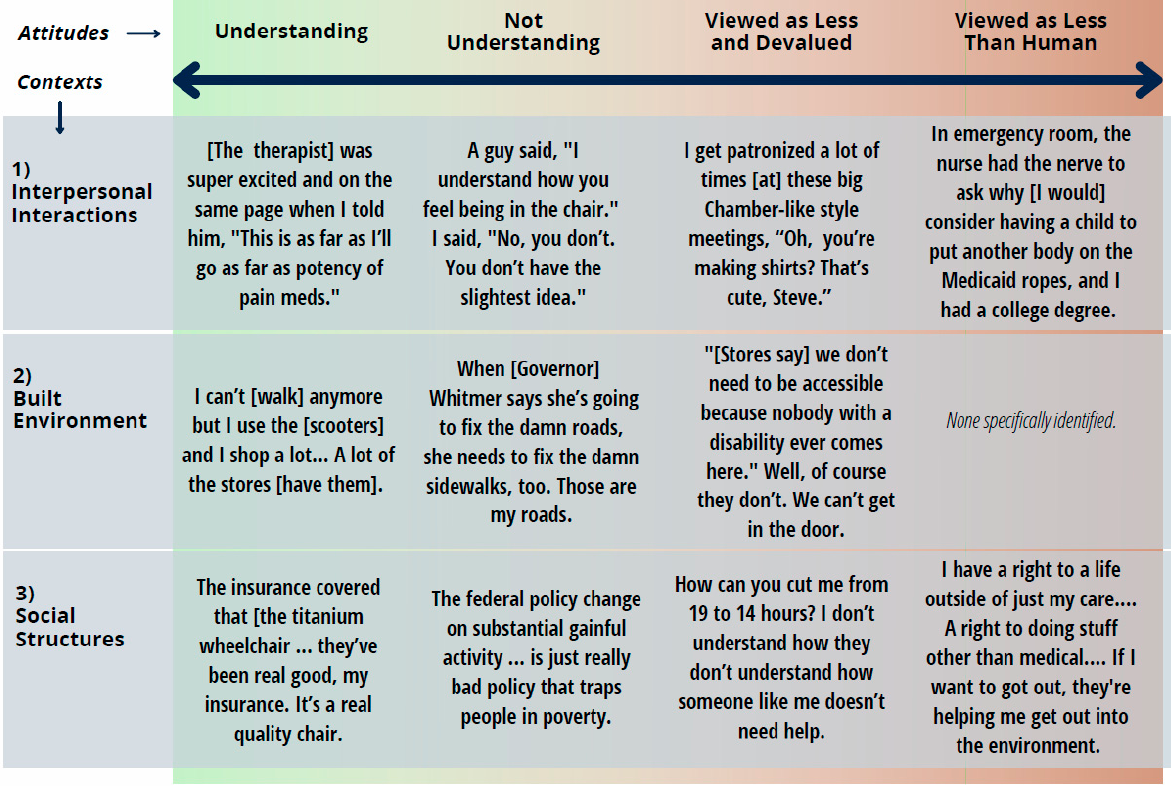
Figure 1. Range of contexts and spectrum of attitudes.